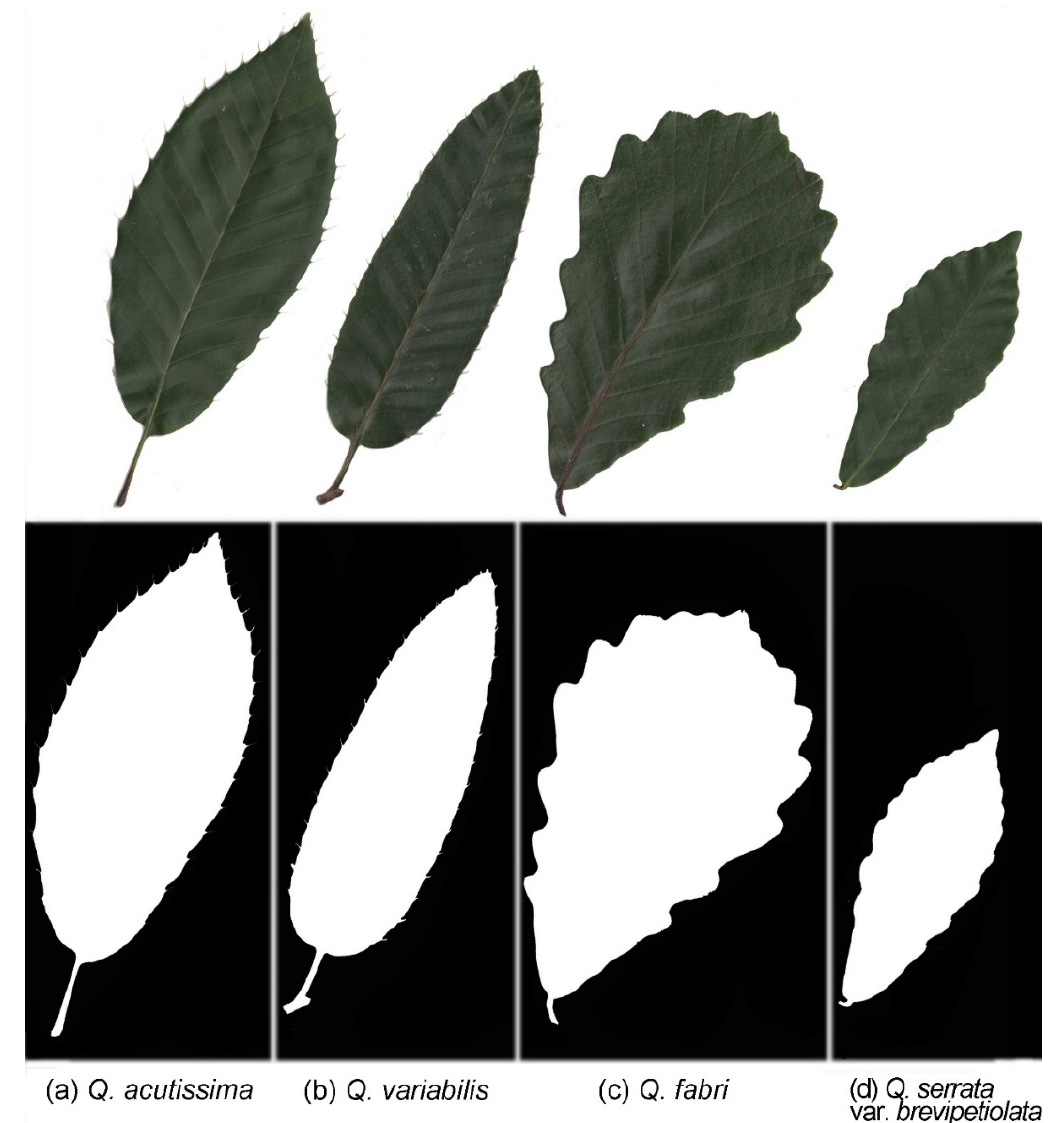
Figure 2. Representative leaf images of the four-oak species (top) and picture of processing formats (bottom). ( a ): Quercus acutissima ; ( b ): Q. variabilis ; ( c ): Q. fabri ; ( d ): Q. serrata var . brevipetiolata .